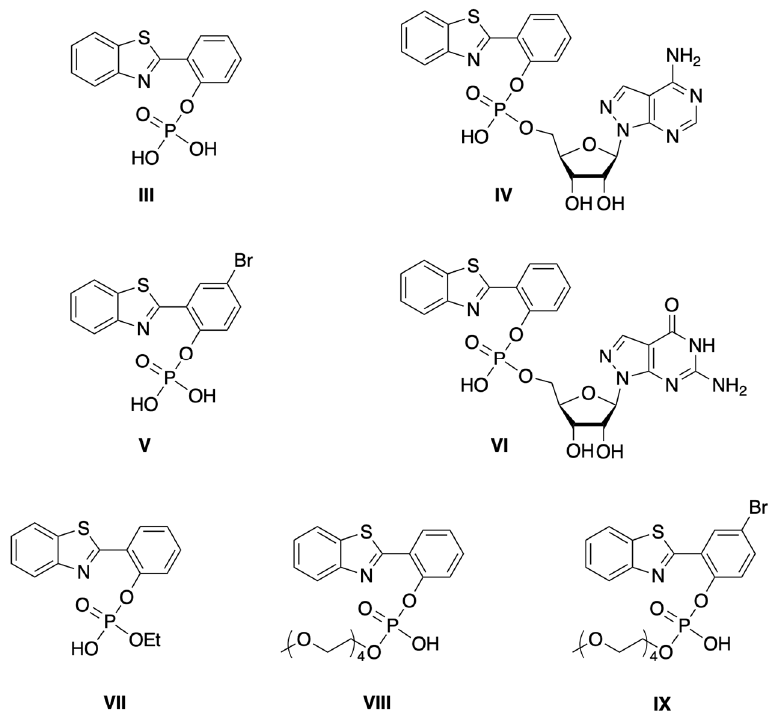
Figure 2. ESIPT process of HBT causing conversion between enol and keto forms. Blocking the hydroxy group by phosphorylation, as shown for III – IX , can trap the HBT unit in the enol form and prohibit the ESIPT process. (Figure 3) [29,32,34,35]. Enzymatic cleavage of the phosphoryl group unveils the hydroxy group, and the HBT unit can undergo ESIPT with accompanying emission, typically in the green region (Figure 4).